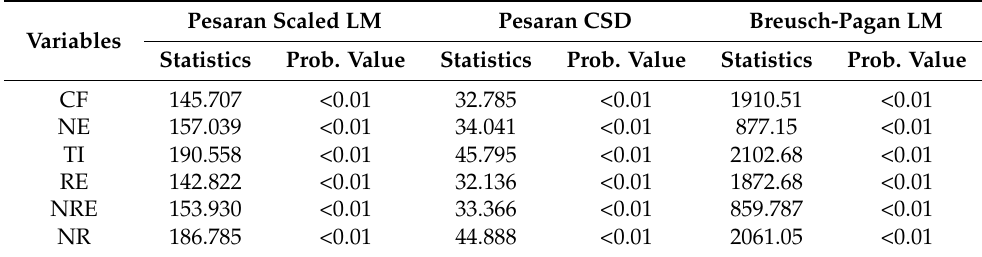
Table 4. The results of cross-sectional dependence tests.